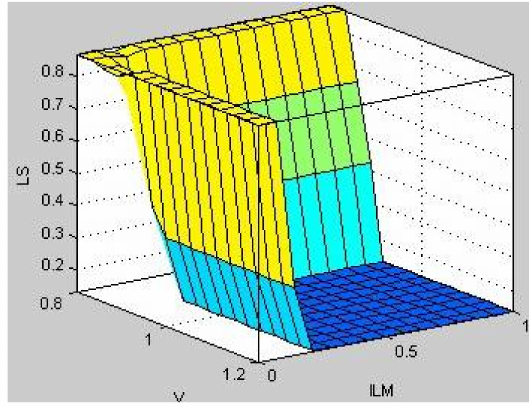
Figure 6. The surface of the fuzzy load-shedding controller.